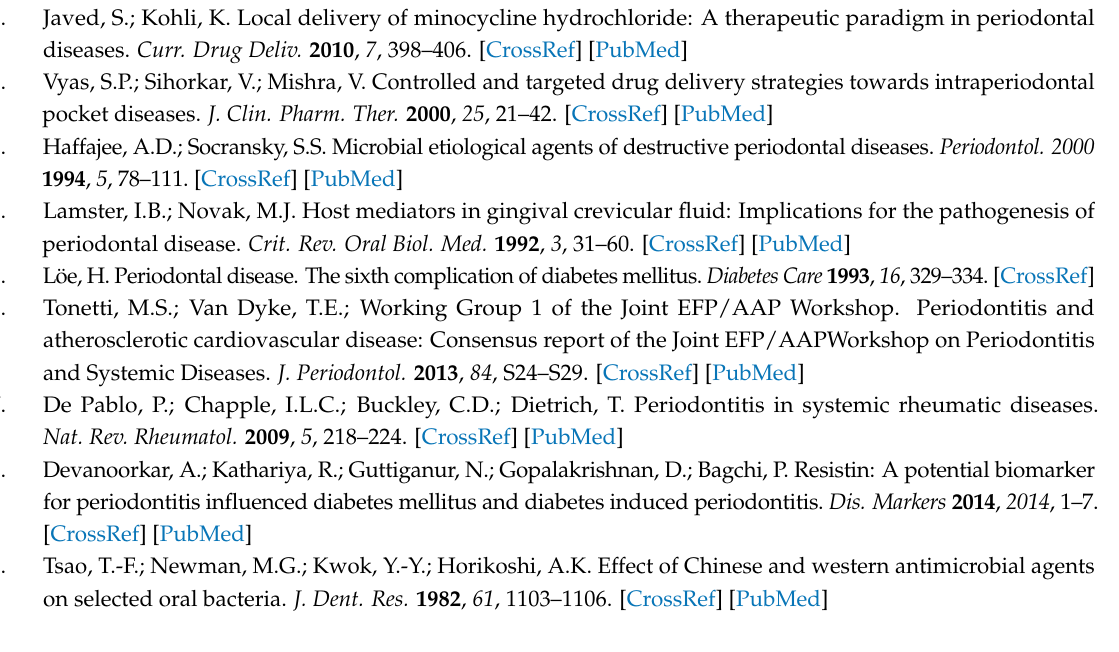
Supplementary Materials: The following are available online. Figure S1: Saturation solubility profile of Qquercetin in various oils, Figure S2: Saturation solubility profile of Qquercetin in various surfactants and cosurfactants, Table S1: Composition of various formulation